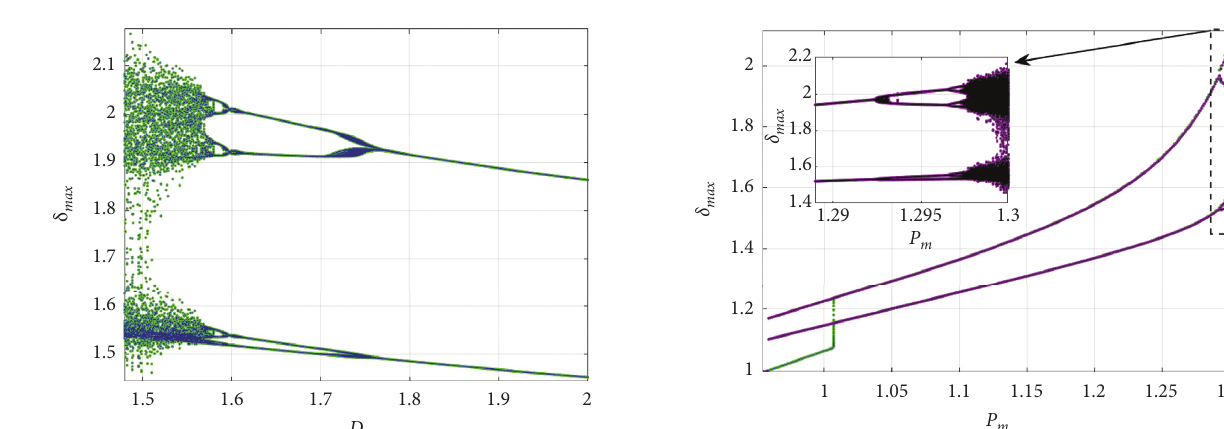
Figure 5: Time series responses for fractional-order power system (10) with q figure legends.